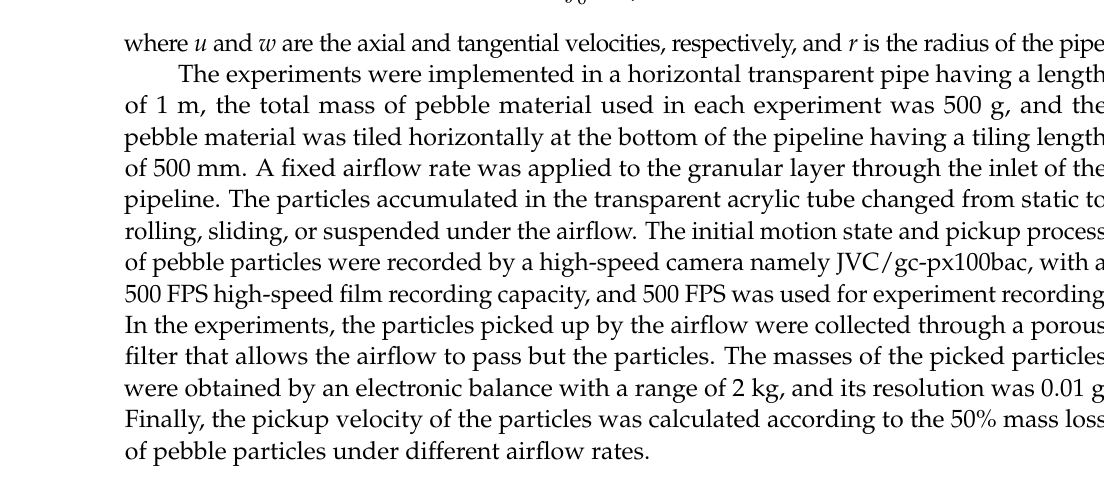
Figure 5. Schematic of experimental measuring domain.